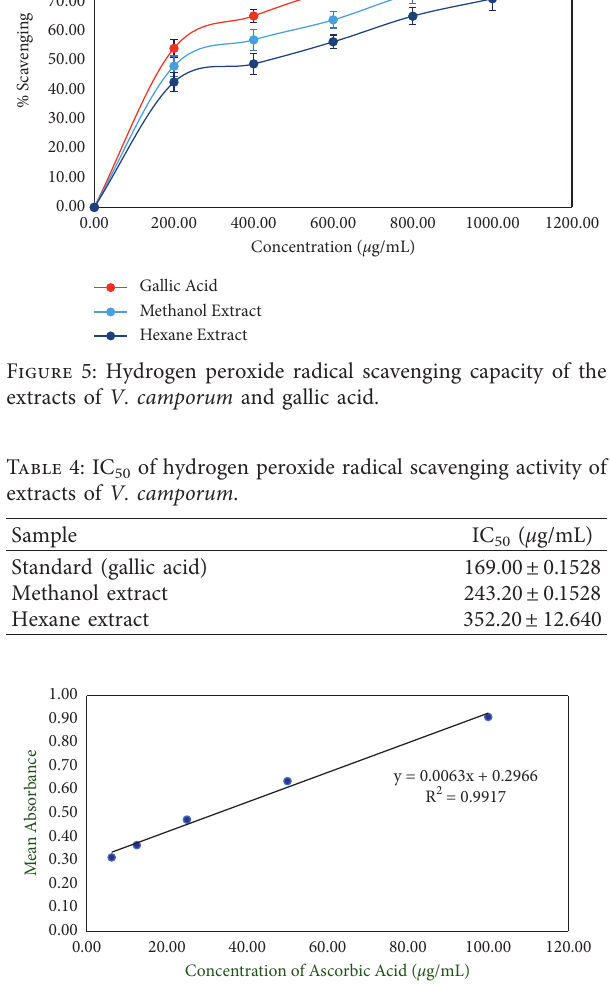
Figure 6: Mean absorbance of PMo V ascorbic acid solution) against the concentration of ascorbic acid